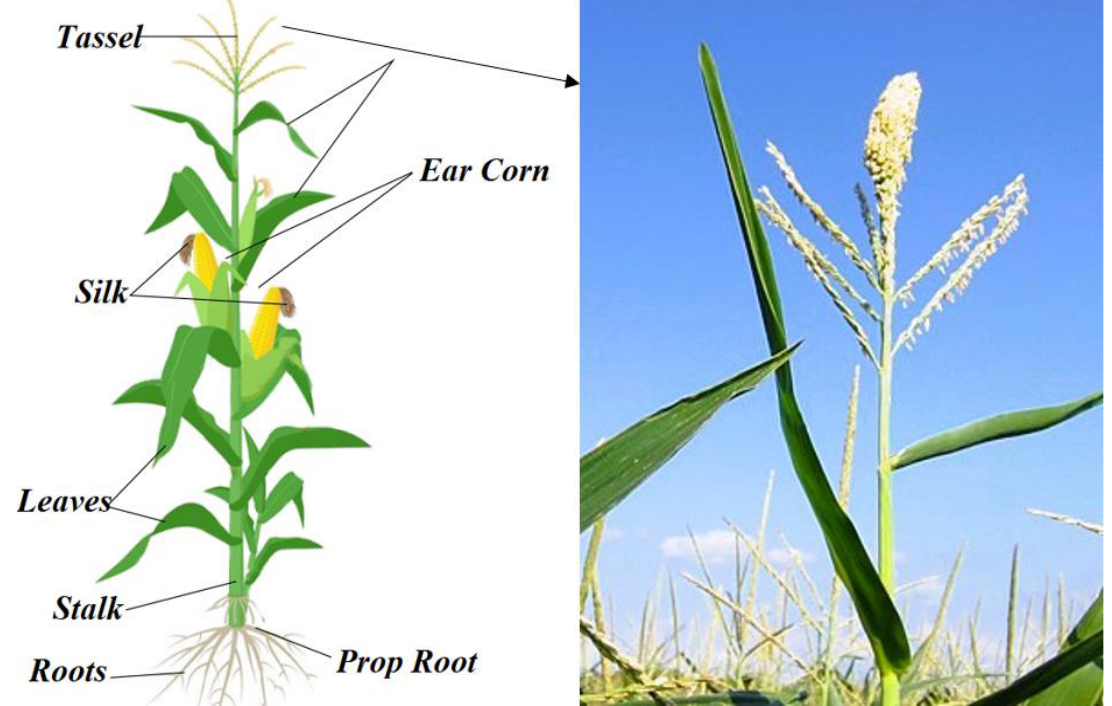
Figure 2. Parts of Zea mays L. and corn tassel.